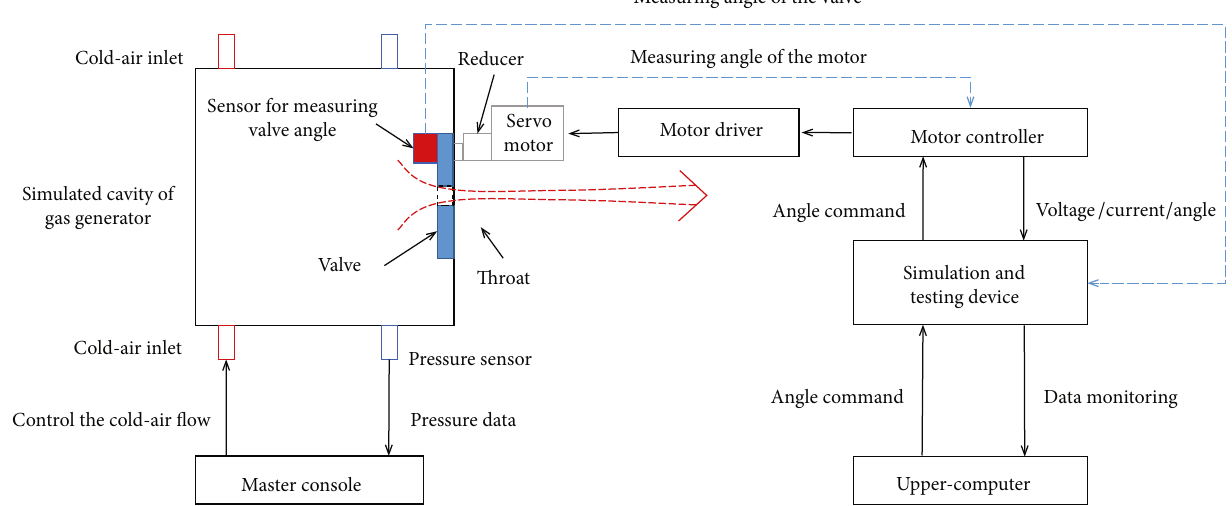
Figure 5: The working principle of the cold-air experiment device.